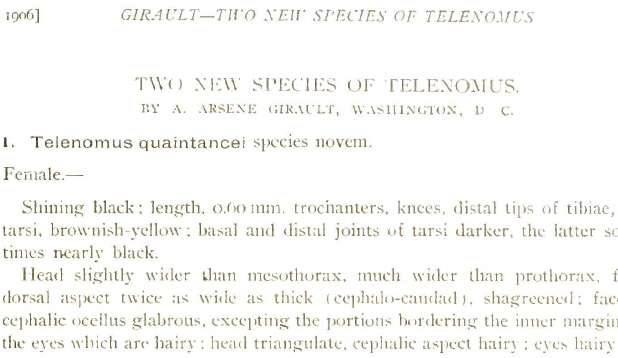
Shining black: length. O.!Jo 111111. trochanters, knees, distal tips of tibiae, am] tarsi. browni~h-yello\\'; ba~al and distal joints uf tarsi darker, the latter some times nearly black. Head slightly \\'ider lhan mesuthurax, much wider than pruthorax. from dorsal aspect twice a,; \\'ide as thick 1 cephalo-caudad), shagreened; face t<) cephalic ocellus glabrous. excepting the portions bordering· the inner margins of the eyes \\'hich ar<' hairy; head triangulate, eephalic aspect hairy; eye~ hairy and Yery dark red. ocelli inconspicuous, reddish, the lateral ocelli close to, hut nut touchrng. the margin of the eye. Thorax rather ~tout, slightly longer than abdomen, sculpture similar to that of the head. the dorsum \Yith rather dense \\'hitish pubescence. :\lesothorax flattened dorsad, \\'ith a deep cun~pictluus smooth iemural furru\\' un its side. Scutellum smooth, hairy. striate at uuter edges. :\bdomen smooth, polished. first and secund segments. at base, strongly. longitudinally striate. the striations of the second segment not present near the lateral margin of that segment; second segment ]Jy far the largest. une-third \\'ider than long: hairs sparse. \\ hitish. in lateral ro\\'~ at inci~iun~: anal ~egment truncate. .\bdomen depressed.